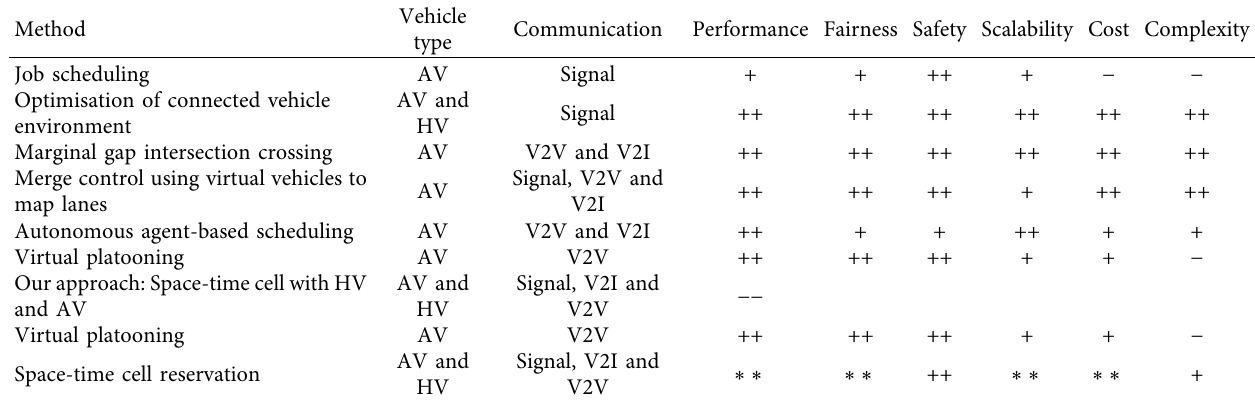
Table 2: Categorisation based on decentralised intersection control.